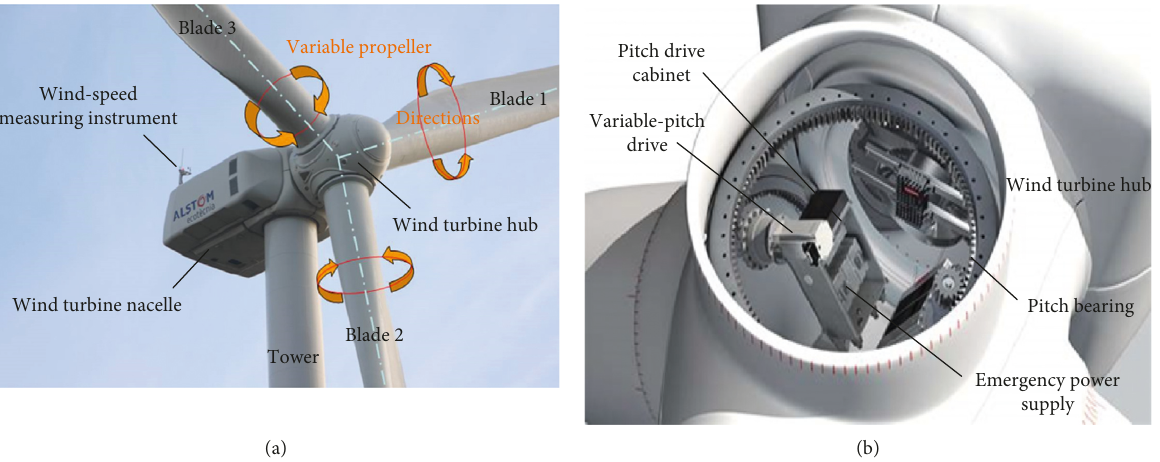
Figure 2: Pitch-controlled system. (a) Blades action under pitch-controlled. (b) Variable-pitch drive system in wind turbine